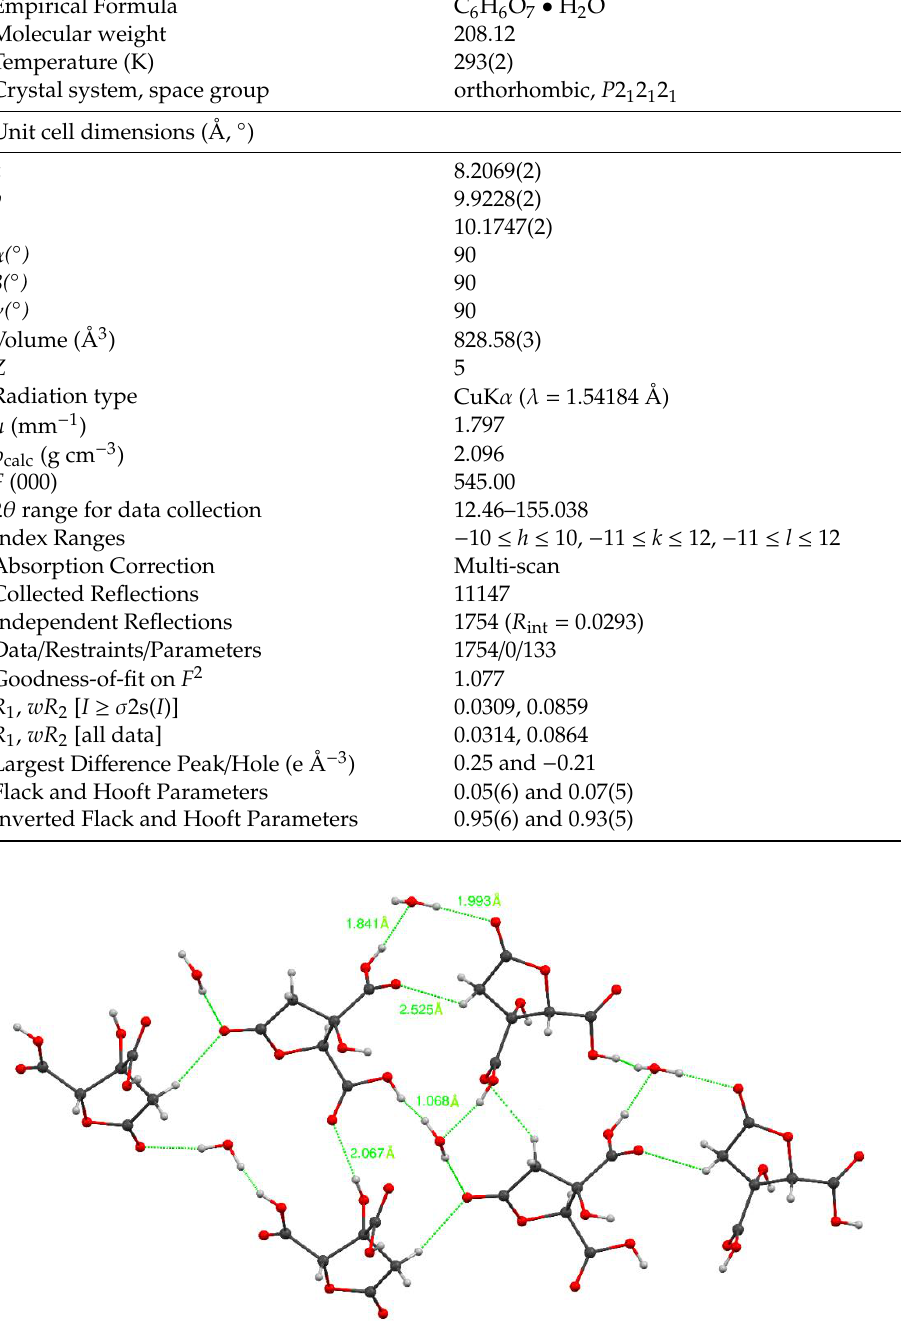
Figure 4. Hydrogen bond contacts of hibiscus acid isolated from Hibiscus sabdariffa . Table 4. X-ray spectroscopy details of crystal data and structure refinement parameters of hibiscus acid isolated from Hibiscus sabdariffa calyx acetonic extract.